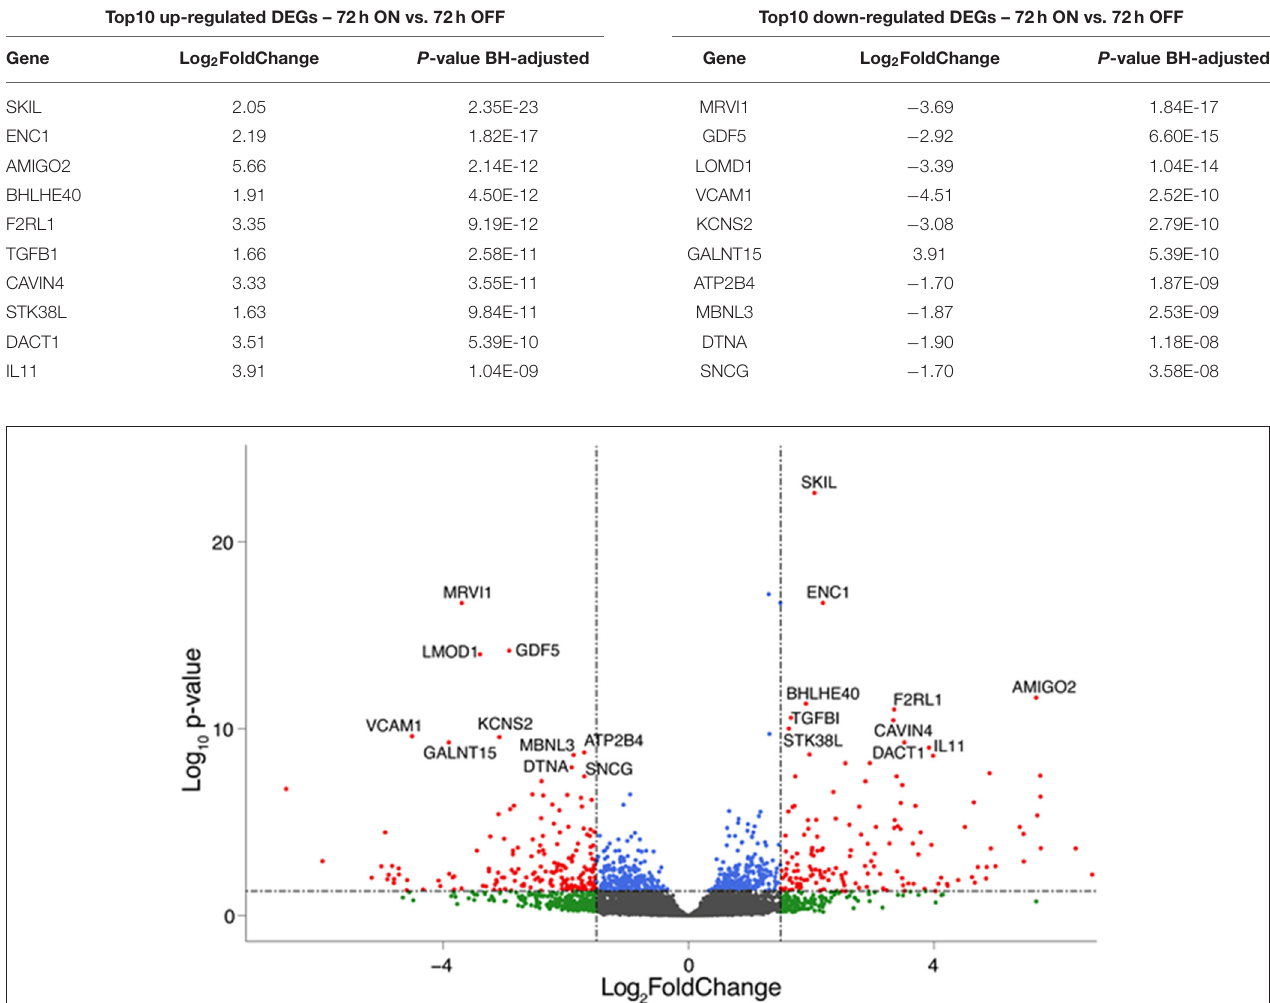
TABLE 1 | Top scored DEGs 72h dyn vs. 72 h stat. Top10 up-regulated DEGs – 72h ON vs. 72h OFF Top10 down-regulated DEGs – 72h ON vs. 72h OFF